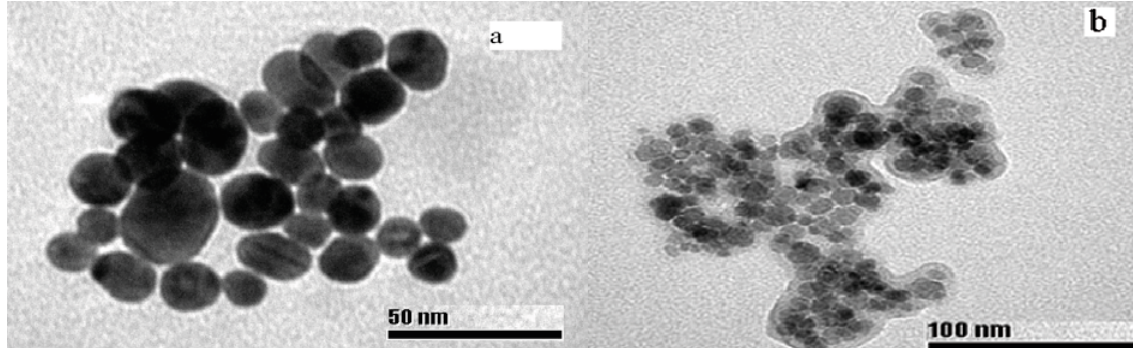
Figure 4. TEM images of (a) NZVI nanoparticles and (b) APS modified NZVI